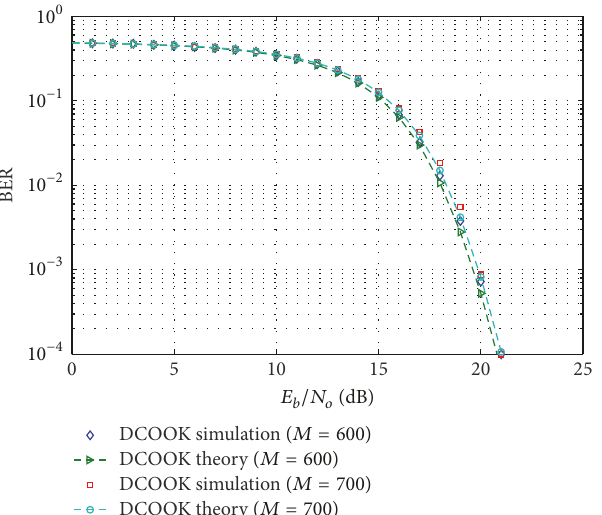
Figure 13: Simulated and theoretical BER performance of DCOOK at 𝑀 = 600 and 𝑀 = 700 .